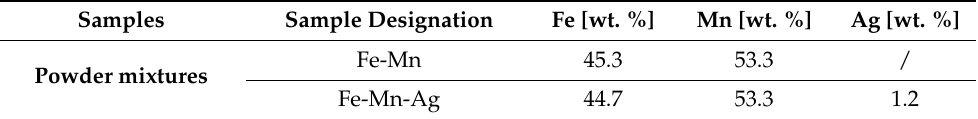
Table 1. Chemical composition of powder mixtures. The remaining wt. % belongs to the oxygen.